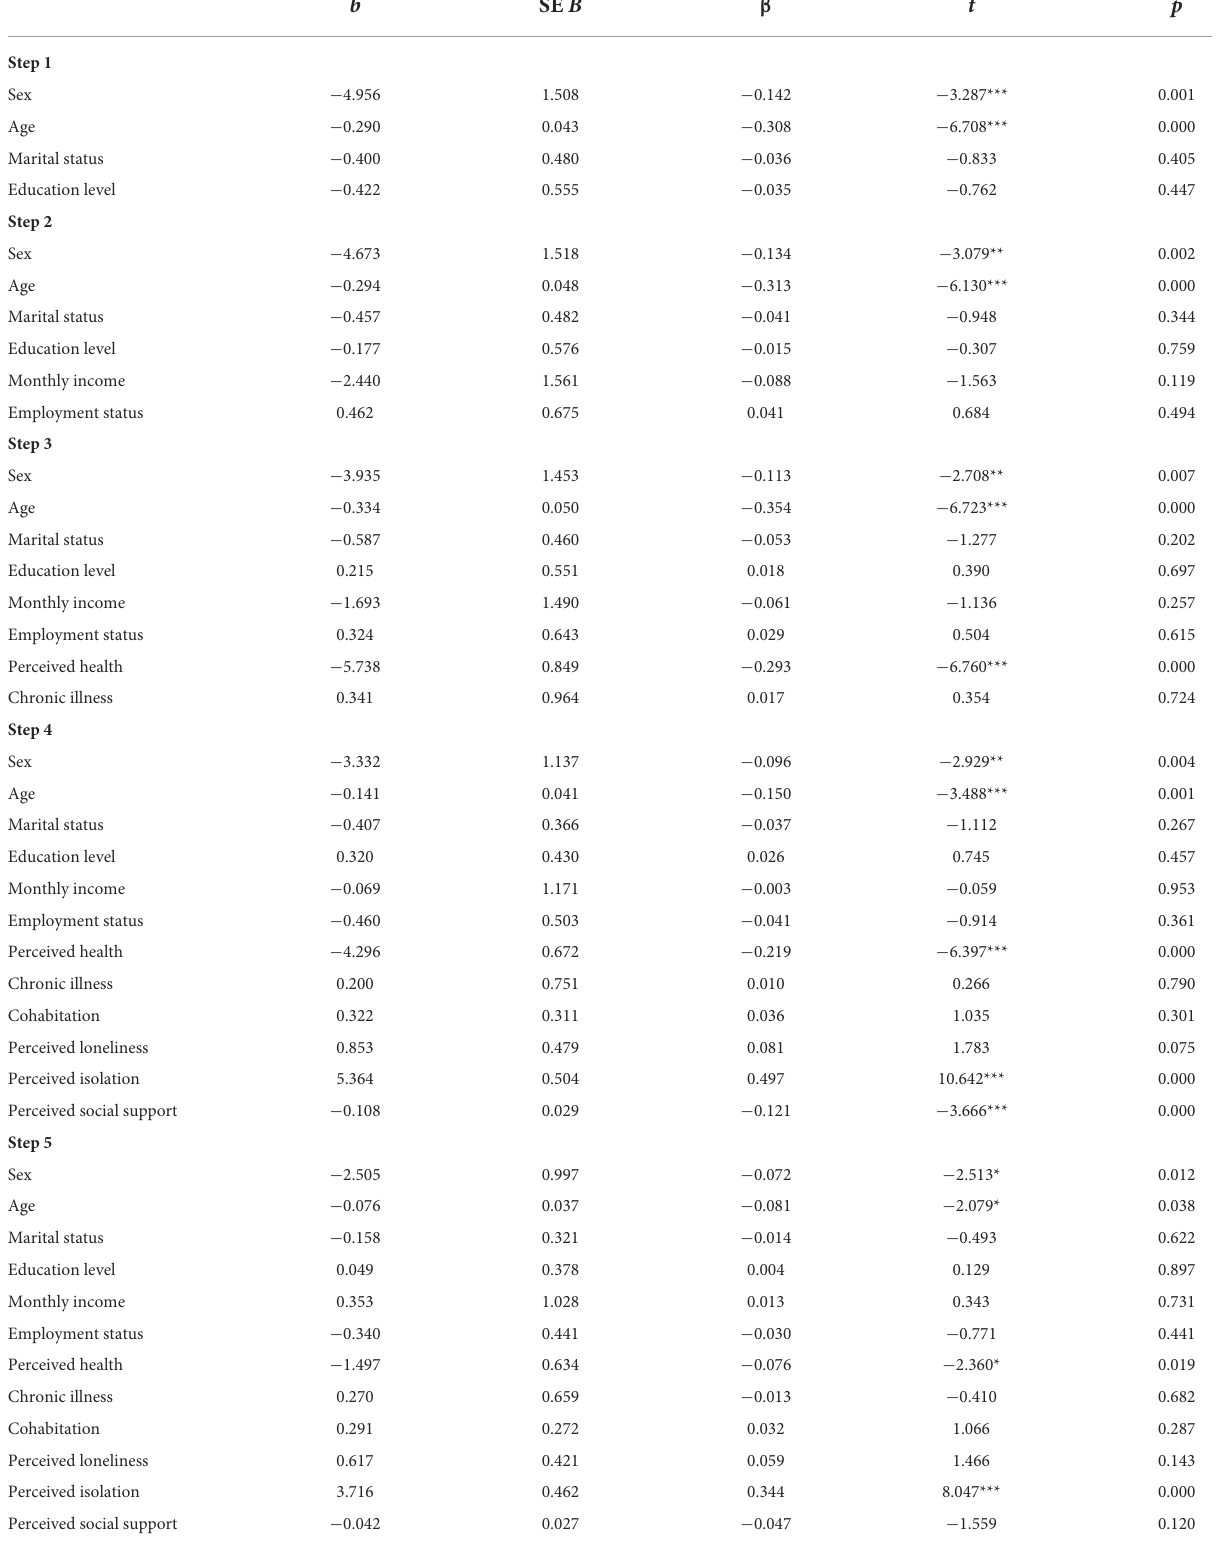
TABLE 4 Hierarchical multiple linear